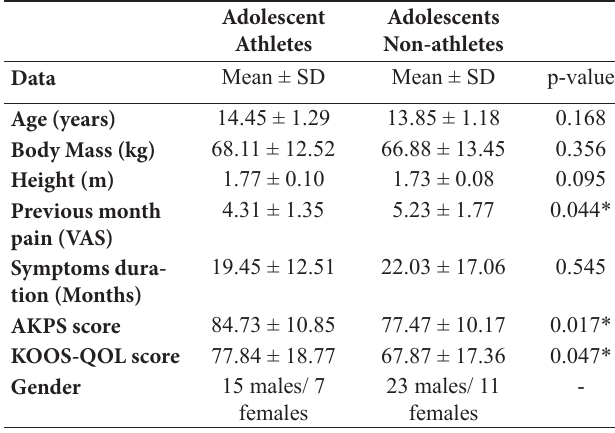
Table 2. Summary of subject